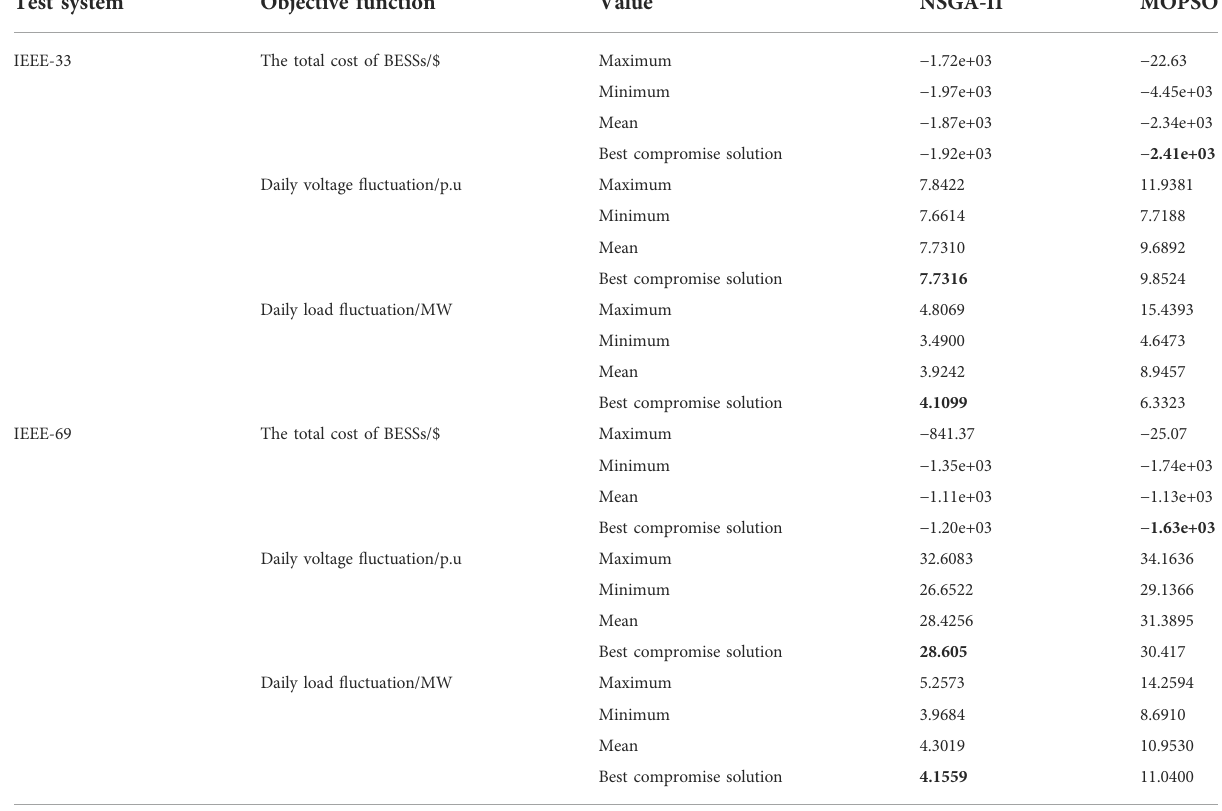
TABLE 7 Pareto optimization results of the model obtained by two algorithms. Test